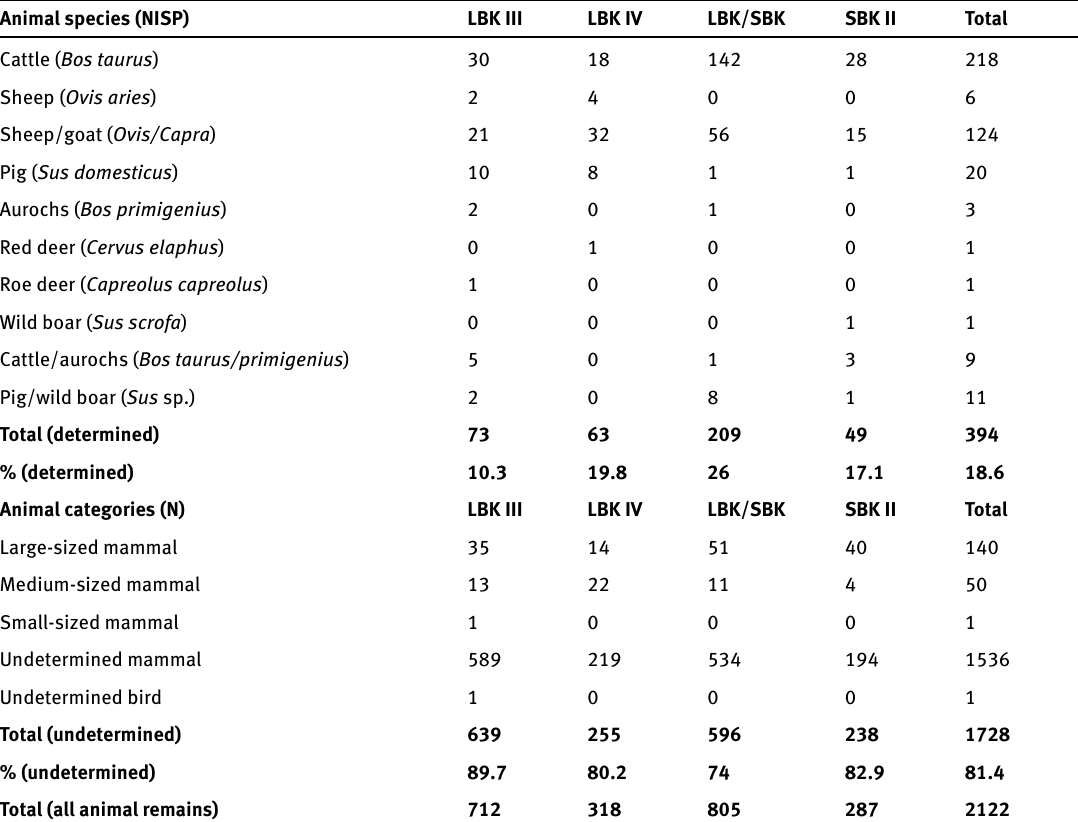
Table 2. List of all taxa recovered in the faunal assemblage from Hrdlovka. NISP (number of identified specimens). N (number of unidentified specimens).